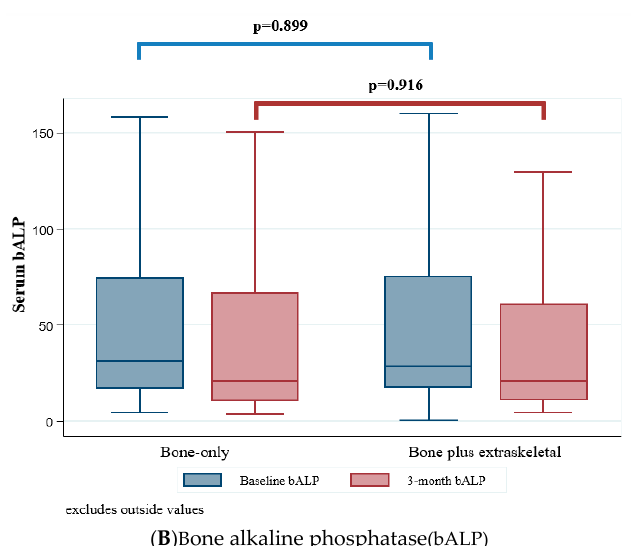
Figure 1. Bone markers at baseline and week 13. ( A ) Corrected uNTX at baseline and week 13; ( B ) bALP at baseline and week 13.bALP, bone alkaline phosphatase; uNTX, urinary N-terminal telopeptide.